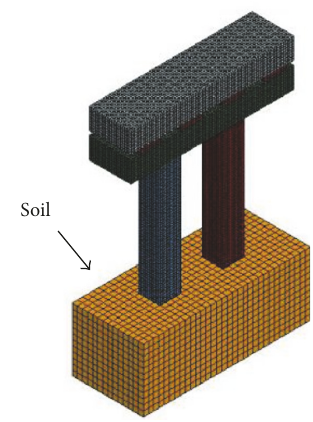
Figure 4: Numerical model of